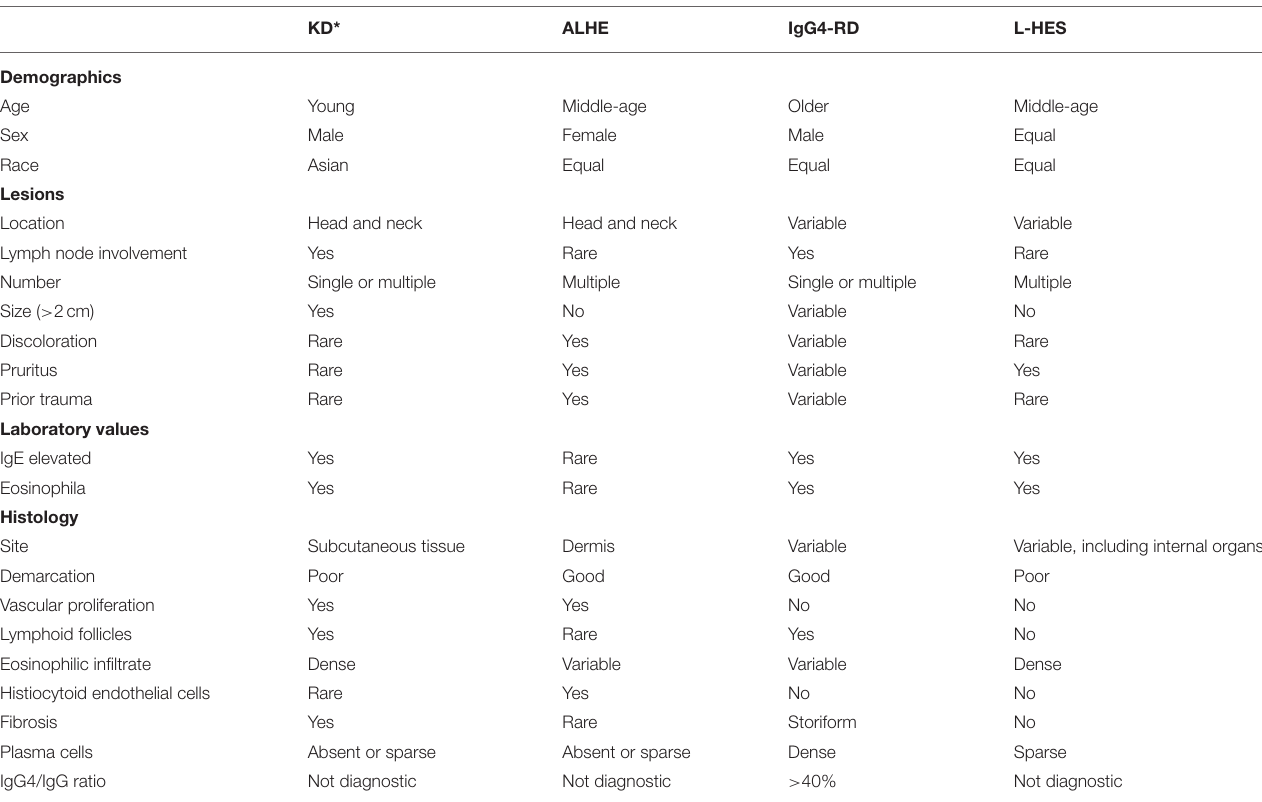
TABLE 2 | Disease comparison (18–20).